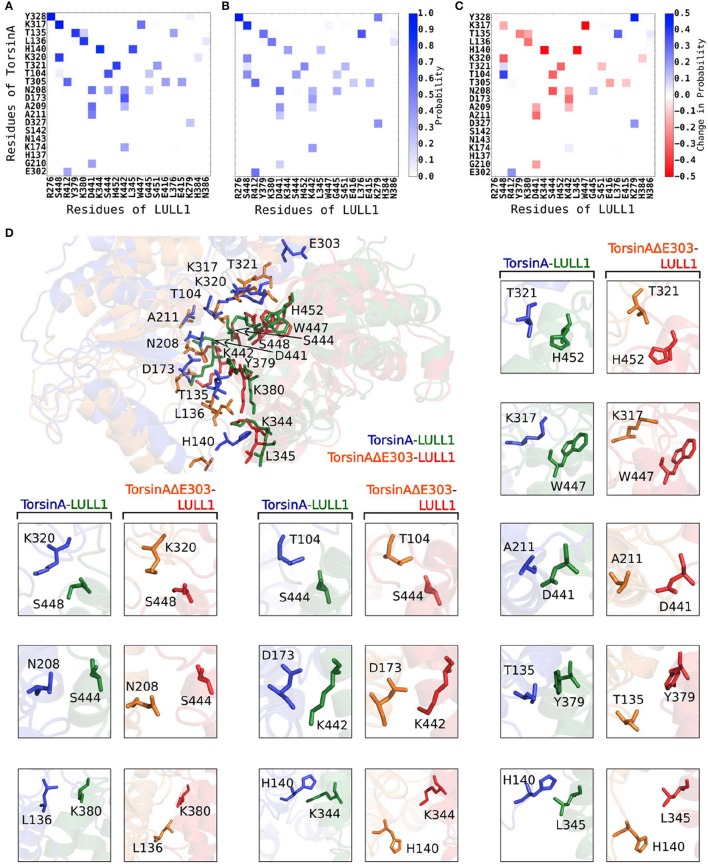
ΔE303 significantly and persistently reduces TorsinAΔE303-LULL1 interactions compared to TorsinA-LULL1 interactions. We show the most active residues (A) in TorsinA-LULL1 interactions and (B) in TorsinAΔE303-LULL1 interactions, and (C) the interactions changes due to ΔE303 (i.e., B − A). The red cells in C indicate the residue-residue interactions that are lower in TorsinAΔE303-LULL1 compared to TorsinA-LULL1. The details of the weakened TorsinAΔE303-LULL1 interactions as compared to TorsinA-LULL1 interactions from a representative frame from the MD trajectory are shown in (D). The first image in (D) show the overall differences in the TorsinAΔE303-LULL1 interactions and the TorsinA-LULL1 interactions. The position of the E303 in the wild type TorsinA (which is deleted from the TorsinAΔE303) is shown at the top of the image. The comparisons of each pair of residues are shown in the rest of panel D with TorsinA-LULL1 interactions shown in blue and green, and TorsinAΔE303-LULL1 interactions shown in orange and red. Only the top 11 most weakened interactions are shown in details.